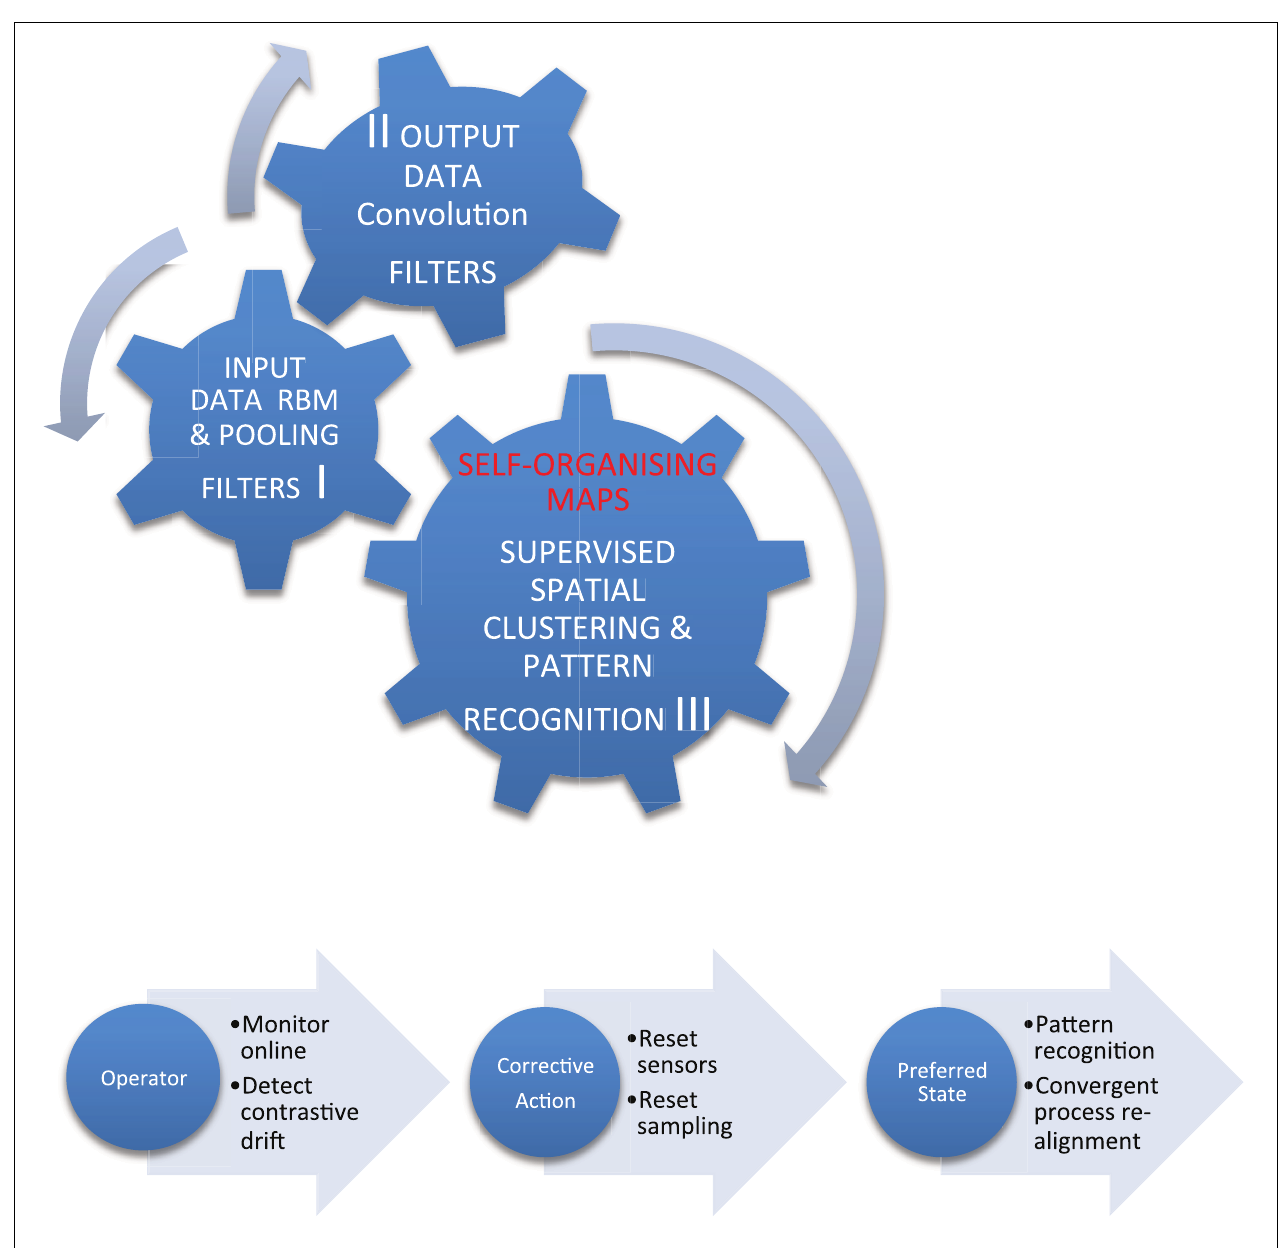
FIGURE 4 | KALEIDOSCOPE function of MLEP with dynamic operator